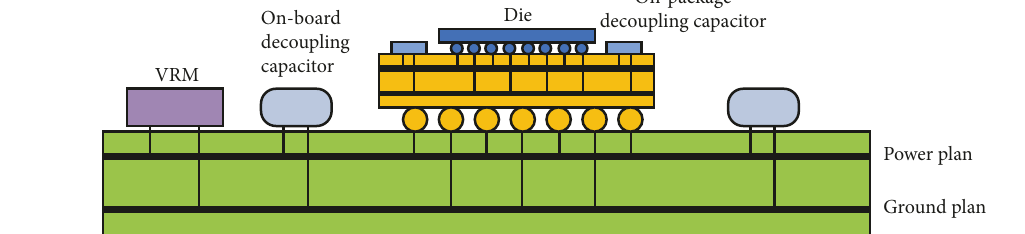
Figure 4: Cross section diagram of PDN.